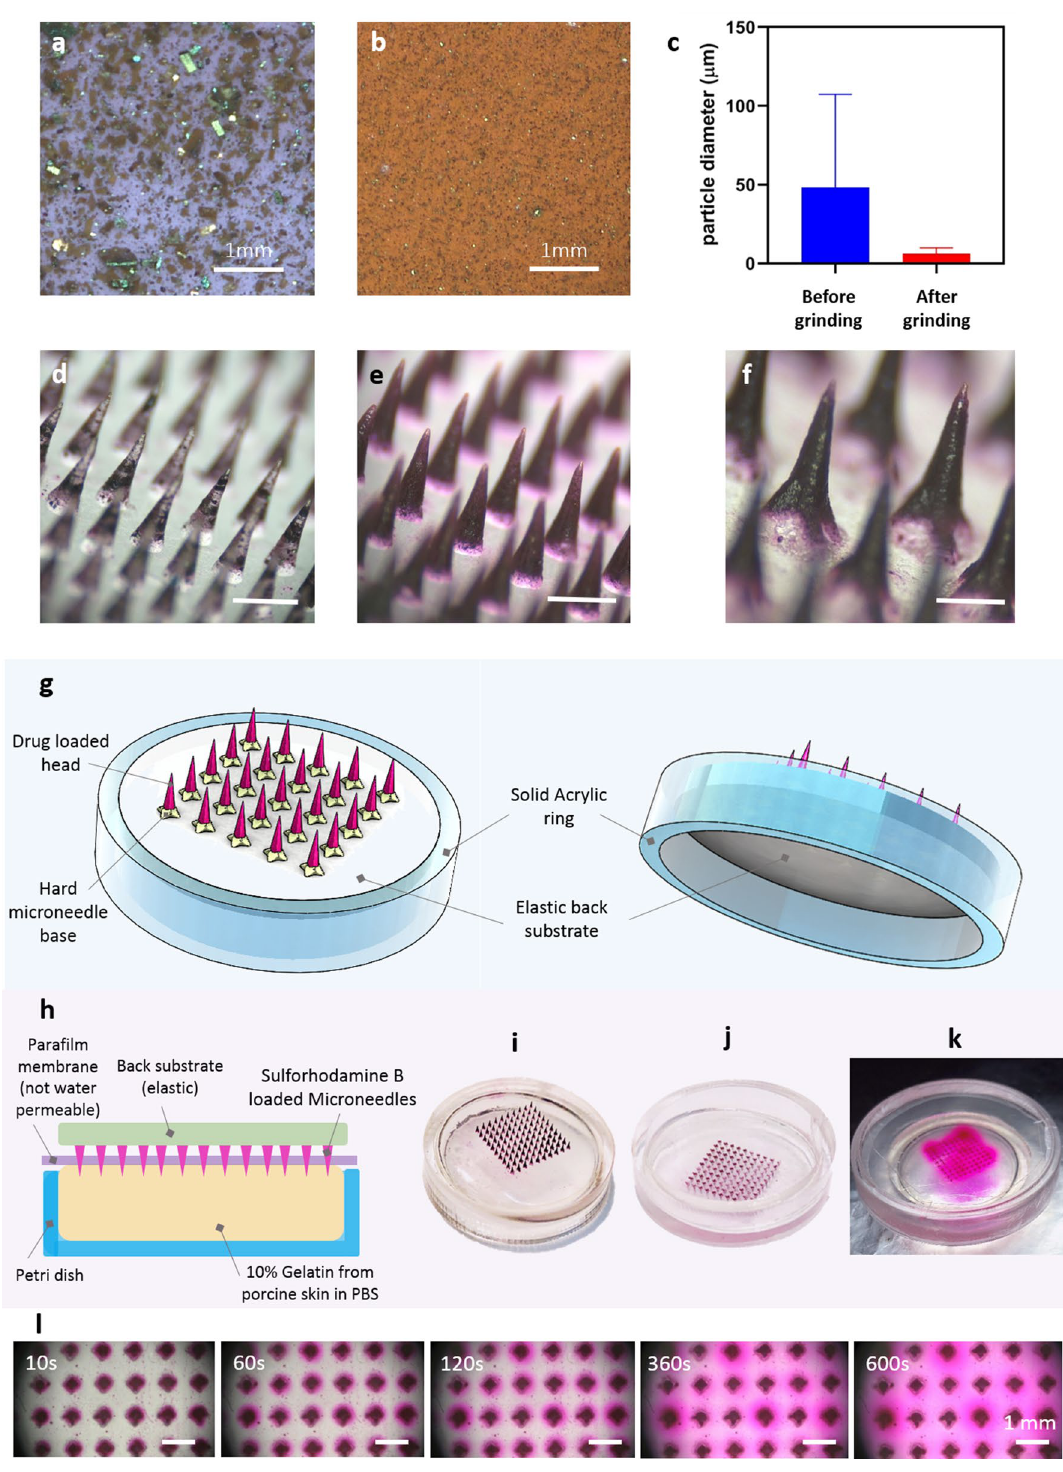
Figure 3. ( a ) Unground Sulforhodamine B particles, ( b ) ground Sulforhodamine B particles, ( c ) particle size distribution of Sulforhodamine B particles before and after grinding, ( d ) microneedles made with unground Sulforhodamine B particles, scale bar of 1 mm, ( e ) microneedles made with ground Sulforhodamine B particles, scale bar of 1 mm, ( f ) microneedles made with ground Sulforhodamine B particles with base structure, scale bar of 0.5 mm, ( g ) schematics of microneedle arrays with elastic back substrate and solid acrylic ring, ( h ) in vitro release experiment schematics, ( i ) front side of dye-loaded microneedle patch, ( j ) back side of dye-loaded microneedle patch, ( k ) release of dye in gelatin after 10 min, ( l ) release distribution of dye-loaded microneedle arrays in gelatin at different time